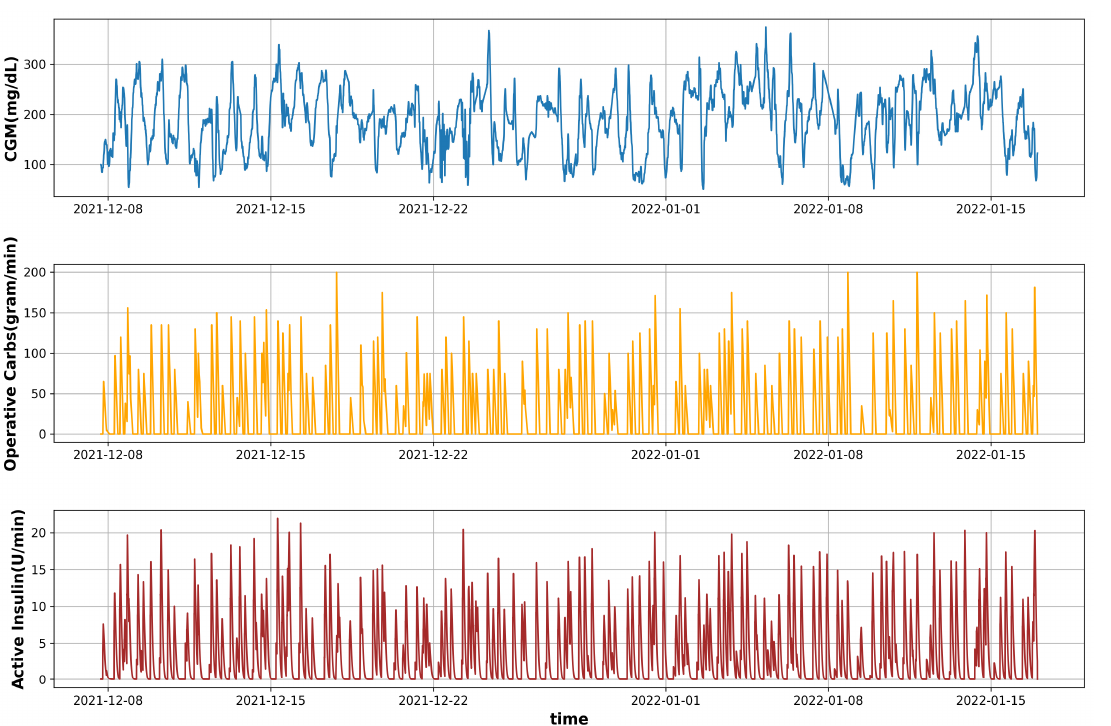
Figure 10. The profiles of CGM, Operative Carbs, and Active insulin in the dataset for patient ID